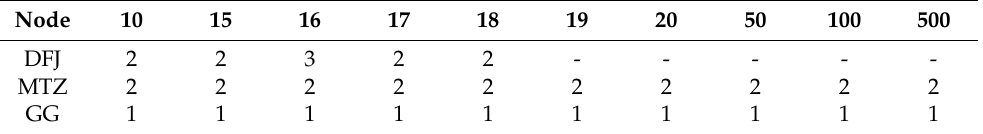
Table 6. Ranking of